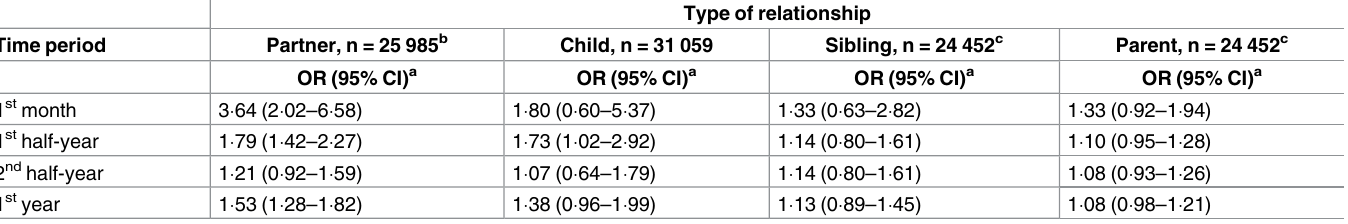
Table 4. Odds ratios (OR) and 95% Confidence Intervals (CI) of suicide after death of a close relative in suicide victims in Sweden, by type of relationship.